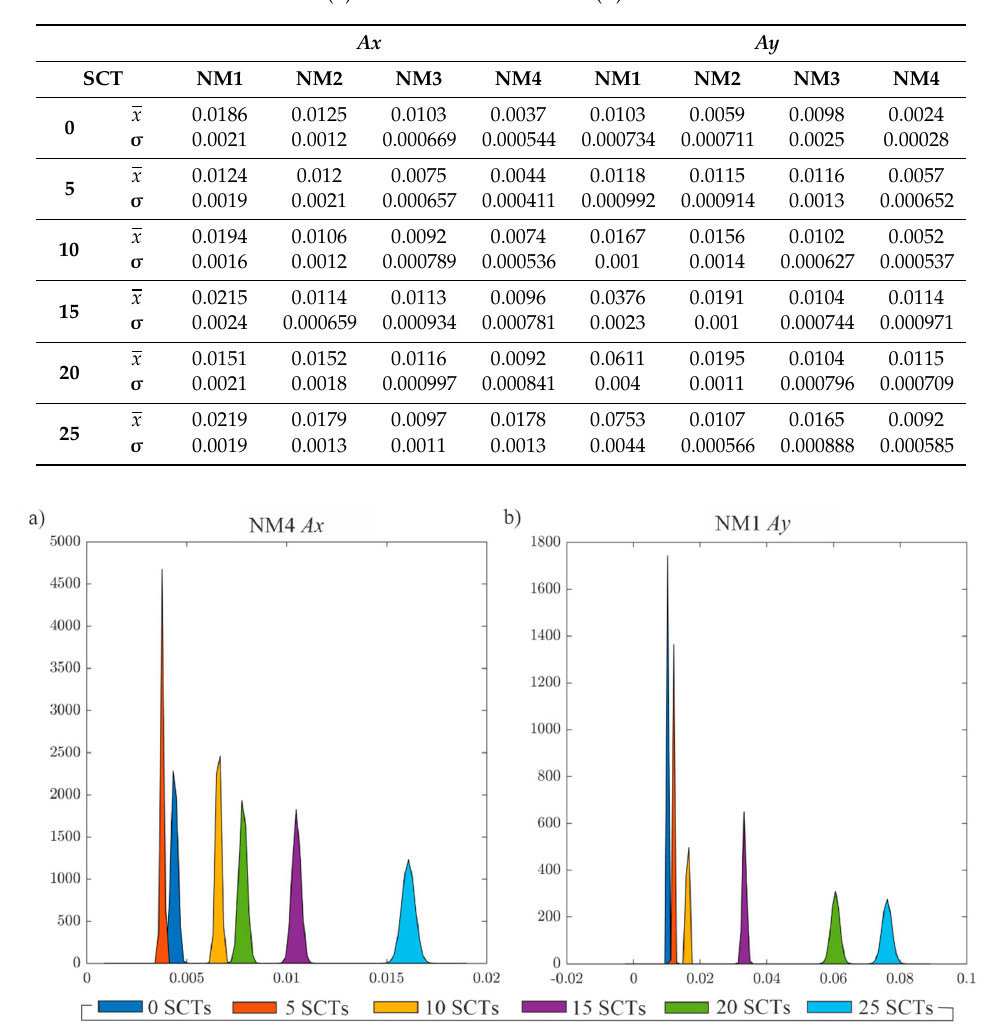
Figure 9. Density functions for ( a ) NM4 of Ax and ( b ) NM1 of Ay .